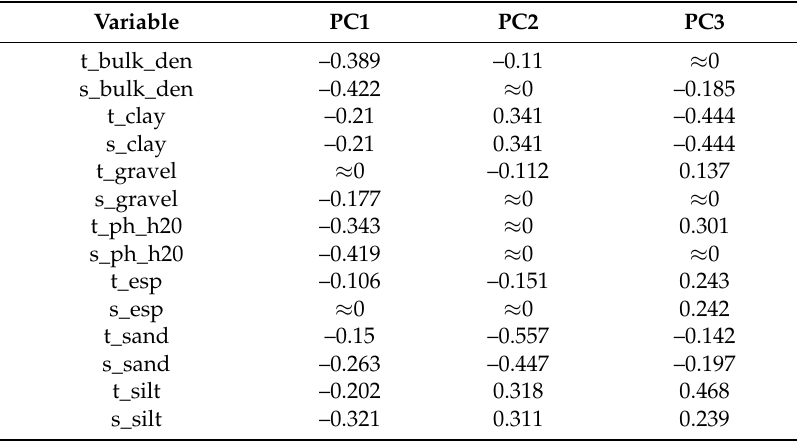
Table A2. Loading factors of 14 soil variables used in the principal component